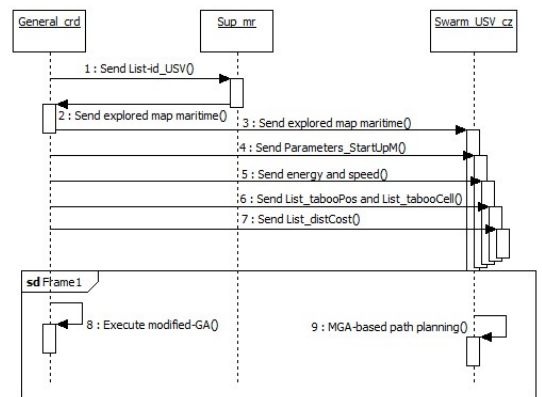
Figure 7: Sequence diagram of the ’modified-GA based trigger process for USV cz swarm’.